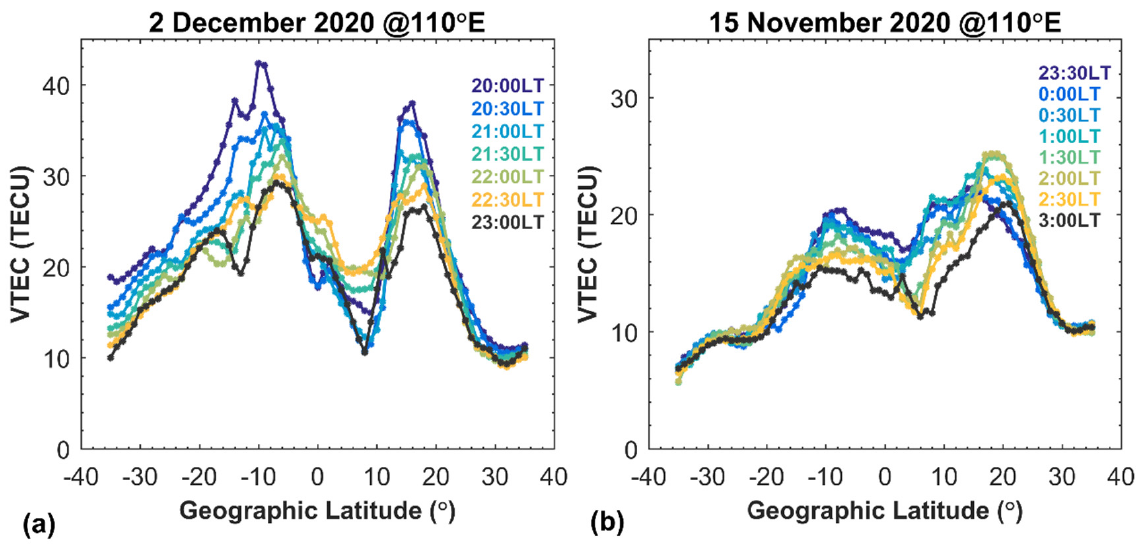
Figure 8. Temporal evolution of cross sections of latitudinal structure of TEC observations along 110° E during the INE event on ( a ) 2 December 2020 and ( b ) 15 November 2020.